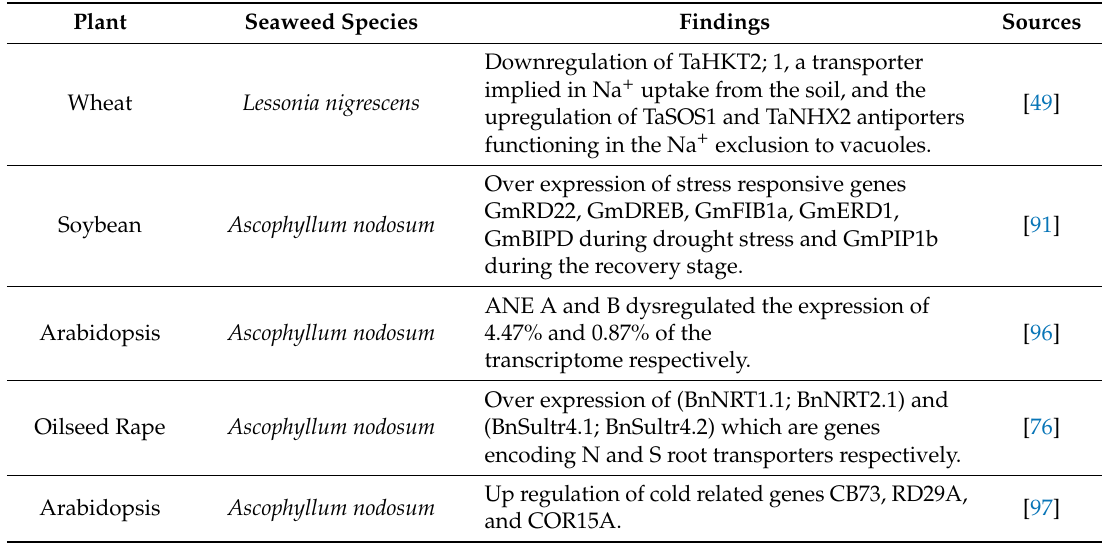
Table 2. E ff ect of seaweed extracts on plants’ gene